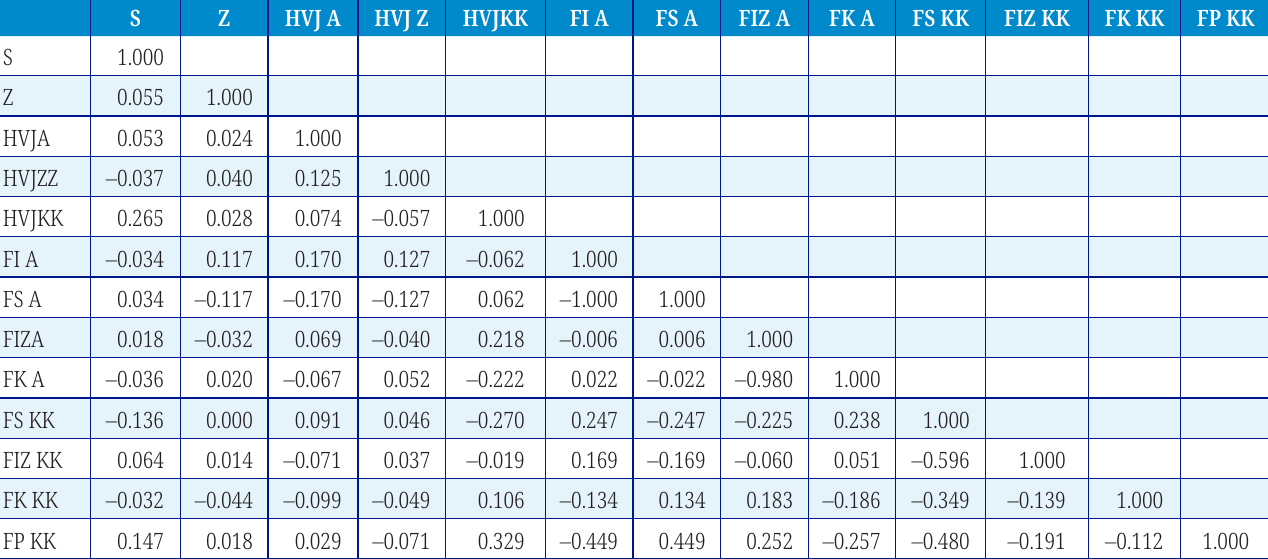
Table 5. Correlation matrix of evaluating the performance and forms of